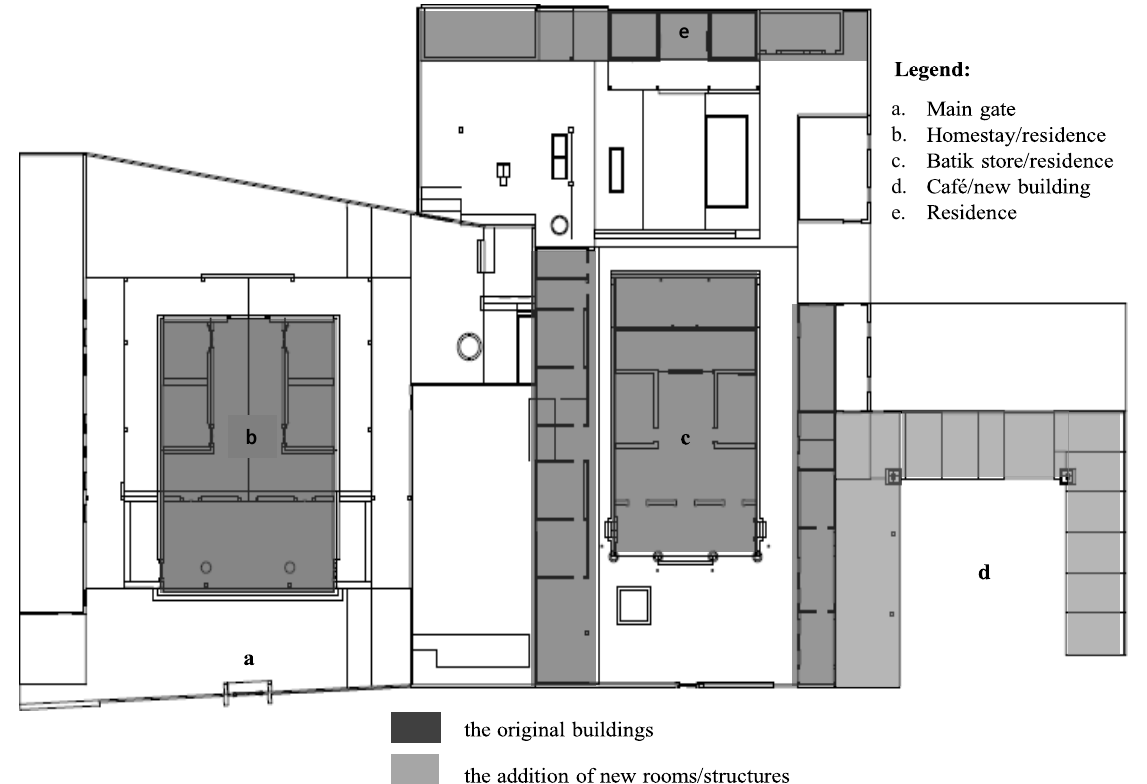
Figure 6. Little China is a large complex with three main buildings: (b) a homestay, (c) a batik store, (d) a new building for café and parking at a vacant land, and (e) the